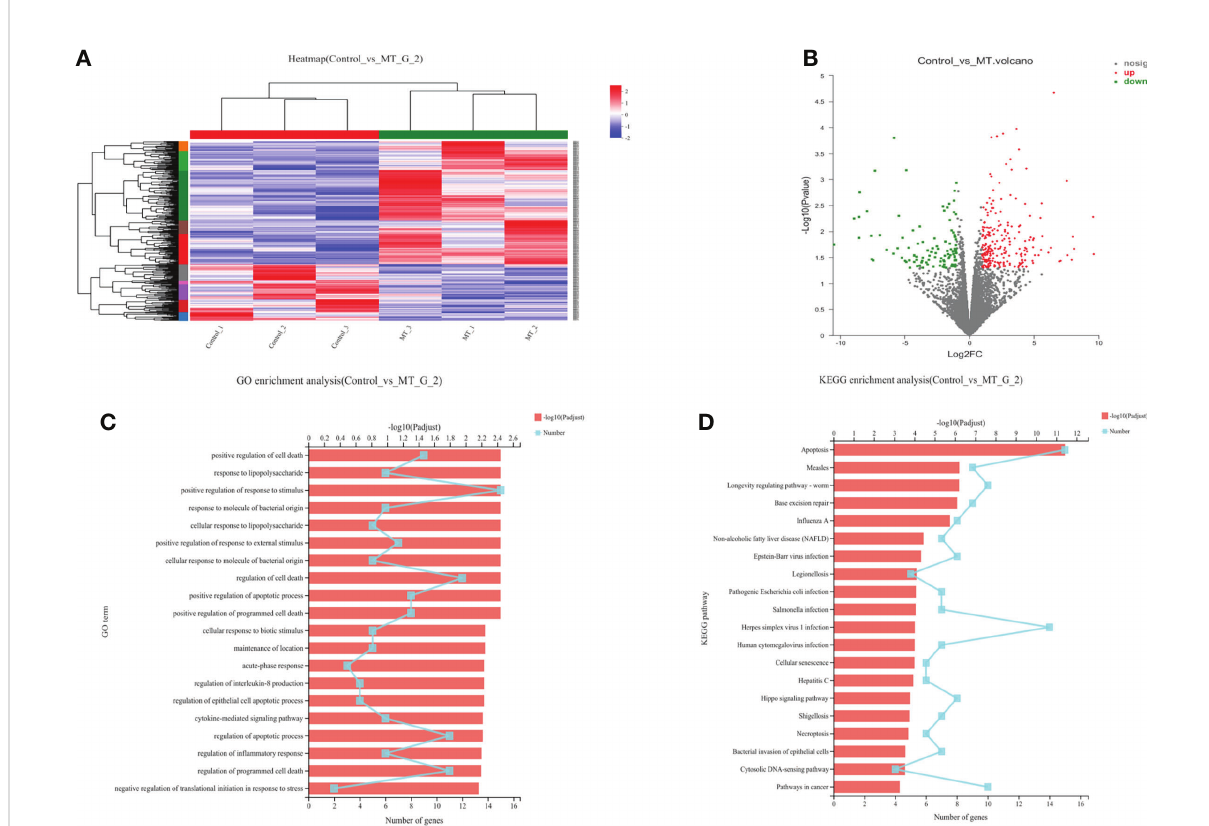
FIGURE 8 Transcriptome sequencing of back muscle tissue. (A) Cluster analysis; (B) Expression difference analysis; (C) GO enrichment analysis; (D) KEGG enrichment